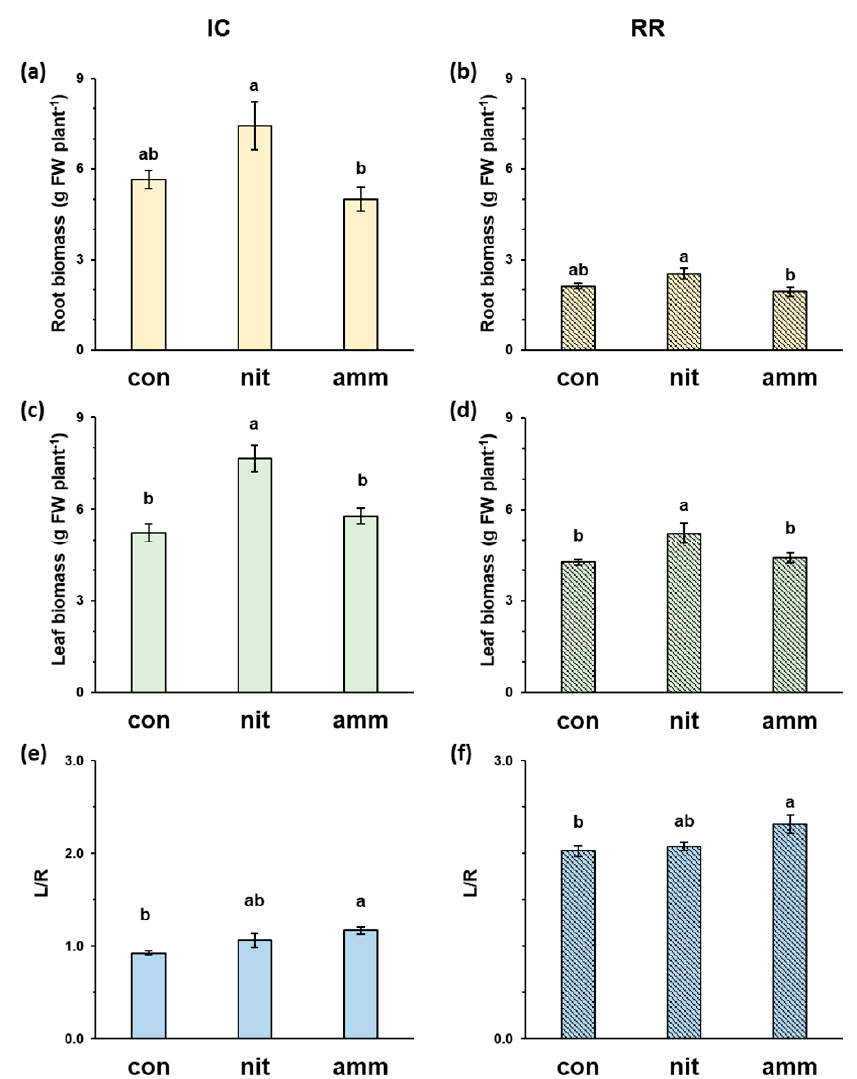
Figure 2. Growth of green and purple basil cultivars exposed to di ff erent N nutritional treatments. Plant growth was evaluated as fresh weight (FW) of roots [( a , b ), yellow bars] and leaves [( c , d ), green bars] per plant (g FW plant − 1 ) and as Leaf / Root fresh weight ratio [(L / R), ( e , f ), blue bars] in the green ‘Italiano Classico’ [IC, ( a , c , e ), open bars] and in the purple ‘Red Rubin’ [RR, ( b , d , f ), hatched bars] cultivars. Plants were exposed for 5 d to absence of N—control [con], 10 mM NO 3 − —nitrate [nit], or 10 mM NH 4 + —ammonium [amm]. Values are the means ± SEM (n = 6). Statistical significance within each cultivar was assessed by one-way ANOVA and Tukey’s test. Various letters indicate significant di ff erences among the di ff erent nutritional treatments ( p < 0.05).